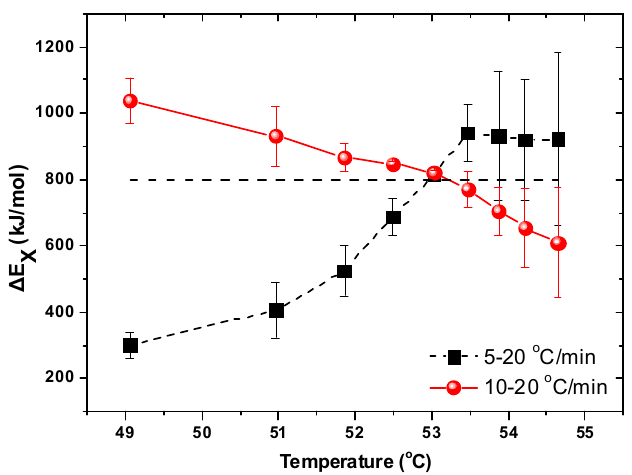
Figure 9. Variation of the effective activation energy with temperature at two different heating rate regimes (i.e., 5–20 and 10–20 °C/min).